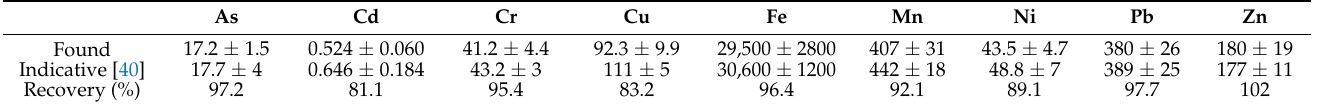
Table 2. Analyte concentrations determined in the GLA URM secondary reference material (mg/kg dry